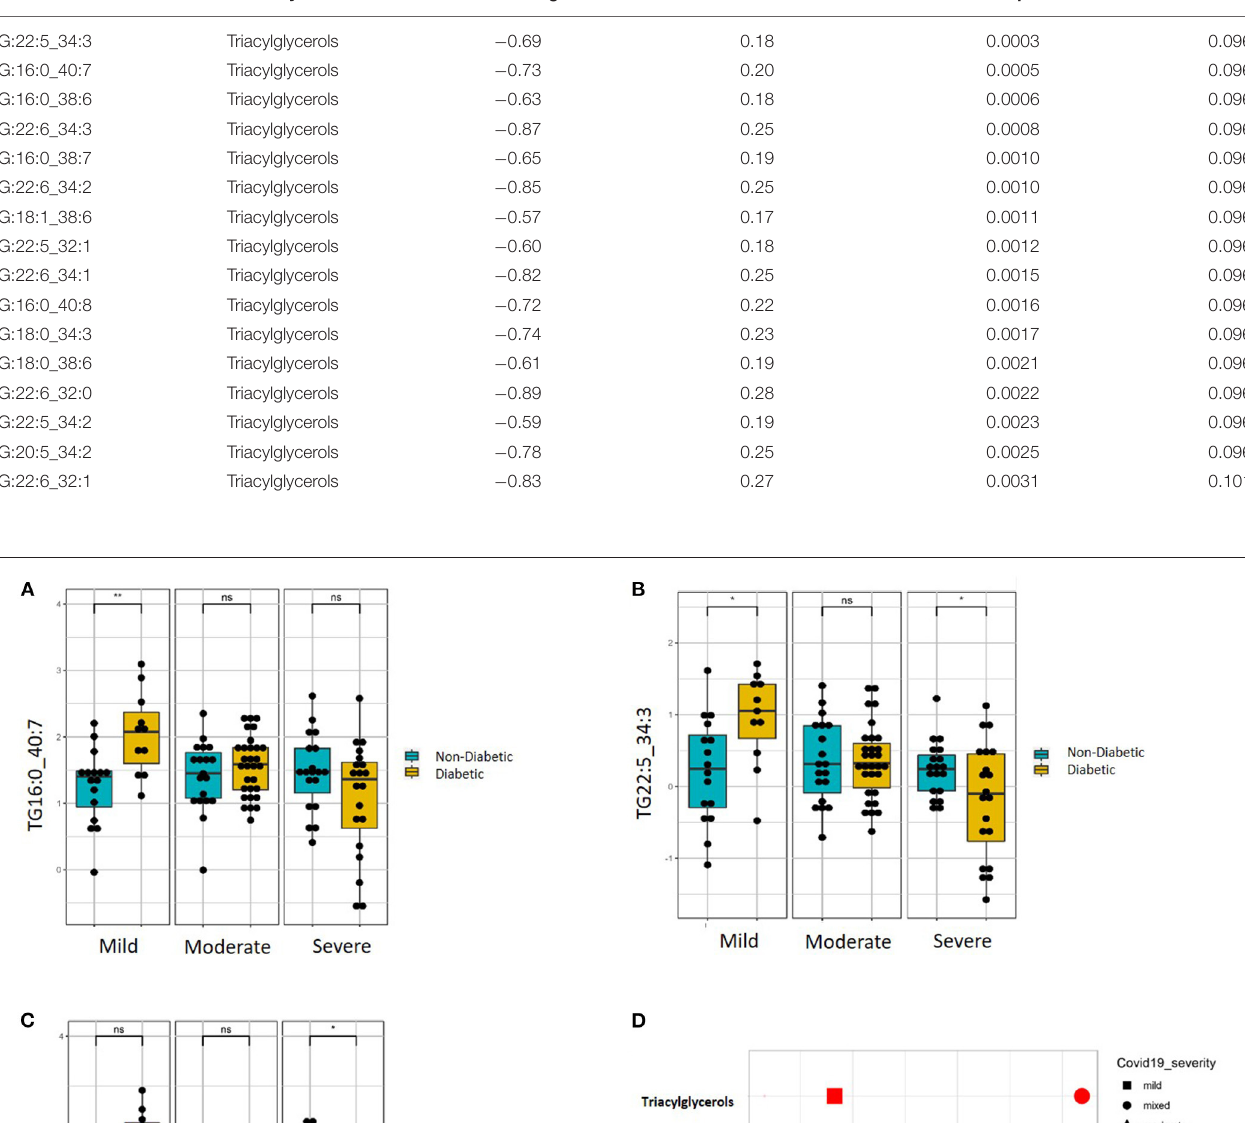
TABLE 2 | Metabolites associated with COVID-19 disease severity in diabetic patients. Metabolite ID